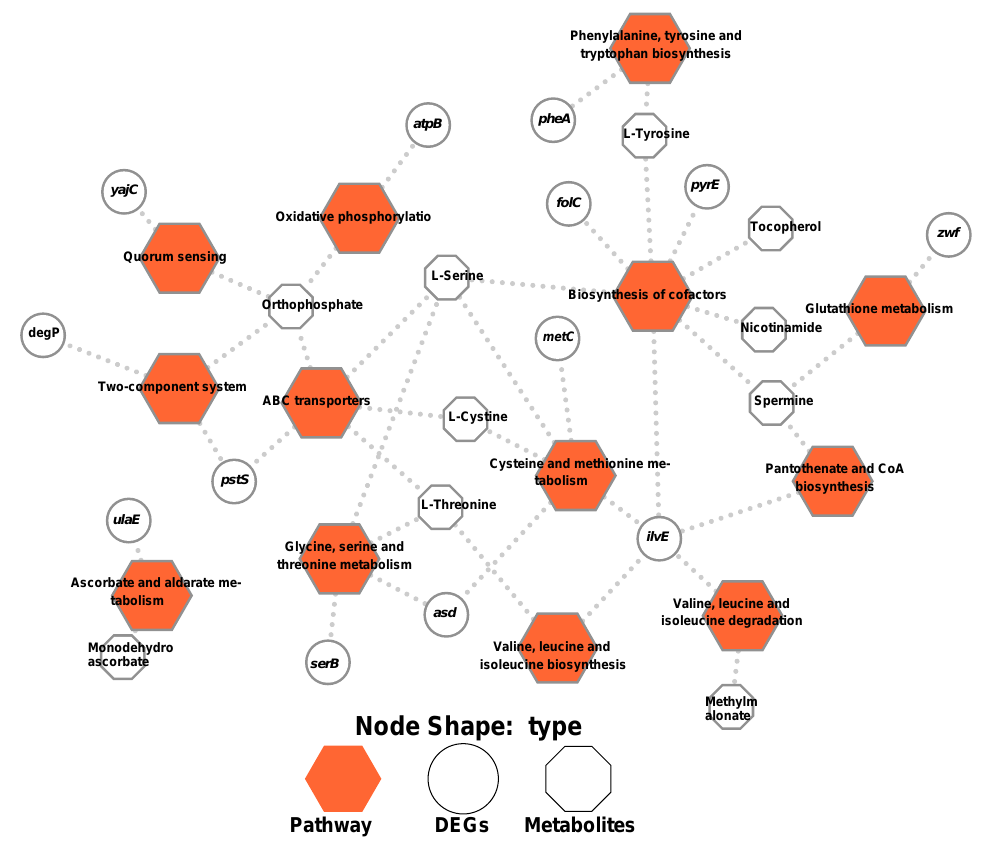
Figure 8. Integration of transcriptomic and metabolomic data. Hexagon, ellipse and octagon nodes indicate KEGG pathways, DEGs and differently expressed metabolites,